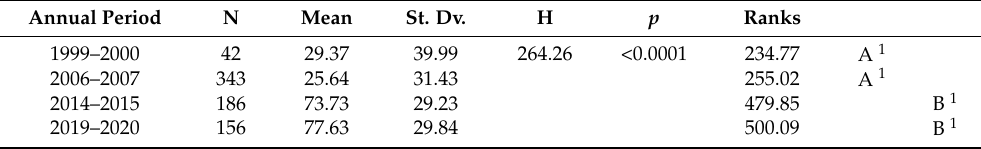
Table A10. Edge Contrast Index’s Kruskal Wallis tests between time periods for the Ituzaing ó district.